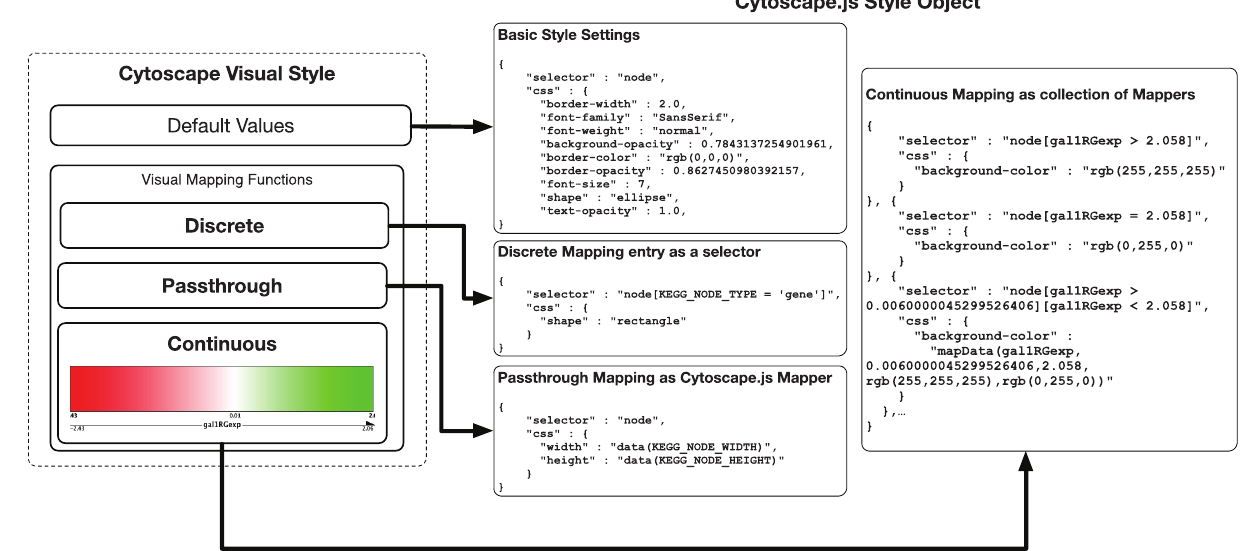
Figure 1. Cytoscape Visual Style to Cytoscape.js Style Object